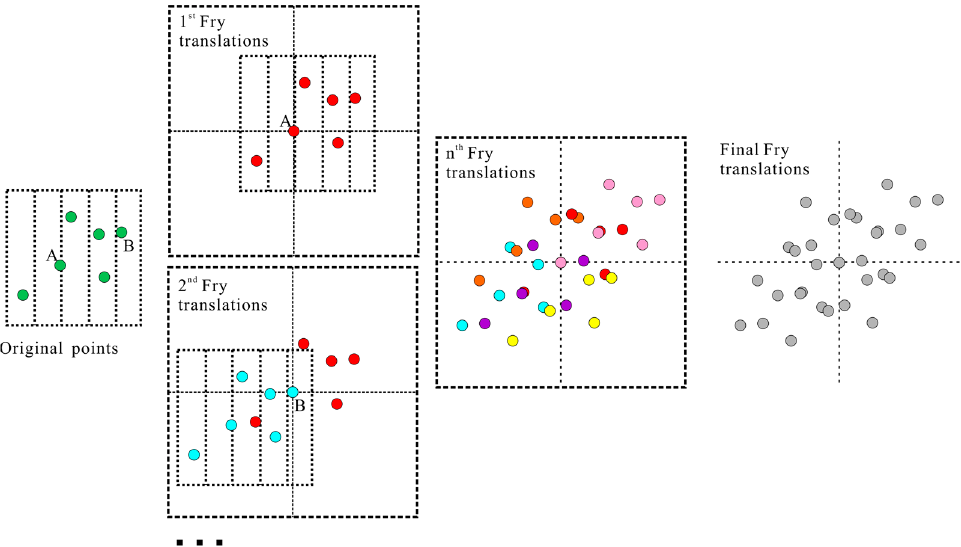
Figure 3. Fry analysis point diagram (modified after carranza [15]).